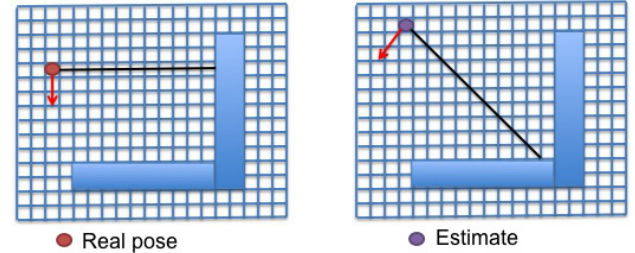
Figure 1. Single measurements obtained by a laser scanner. ( Left ) Real pose; ( Right ) estimated pose. The line representing the laser beam. Table 1. KL computation for the beam orientation shown in Figure 1. Types of cells: free space = 0 . 05 , obstacle = 0 . 95 , unknown space = 0 . 5 . p ( m ) p ( cell ) = p ˆ S ij 2 k